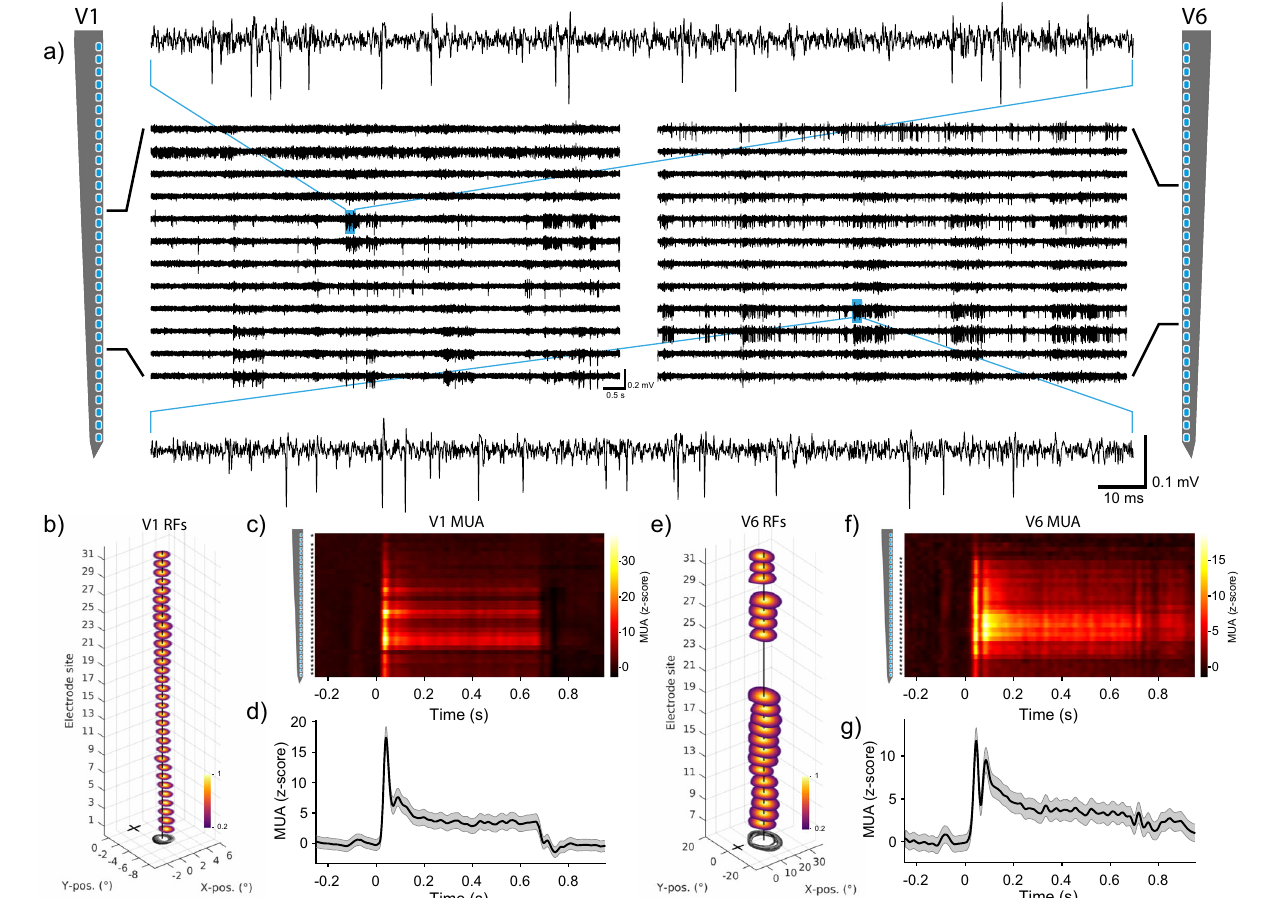
Fig. 5 | Neural recordings in areas V1 and V6. a Band-pass- fi ltered signal (0.3 – 6kHz)fromexamplerecordingsitesacrossoneshankinareaV1(left)andarea V6 (right). The top and bottom traces show a magni fi ed view of the respective example signals in V1 and V6. b Receptive fi eld (RF) locations calculated from the normalized multi-unit-activity (MUA) of all signi fi cantly modulated sites along the example shank ( n =32 out of 32 sites). Outlines of RFs are shown at the bottom in black-to-gray linesfrom most super fi cialto the deepest channel.The verticalblack line indicates the median RF location across all sites. The black cross marks the position of the fi xation point at the center of the monitor. c Trial-averaged MUA along the example shank around the time of visual stimulation with